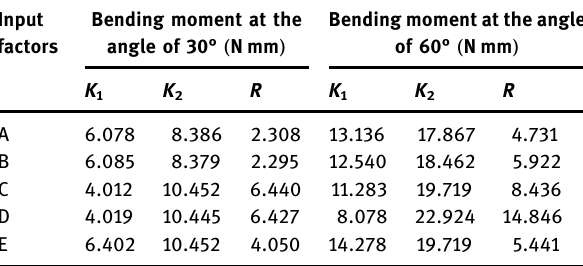
Table 6: Range analysis for the bending moment at the bending angle of 30° and 60° Input Bending moment at the factors